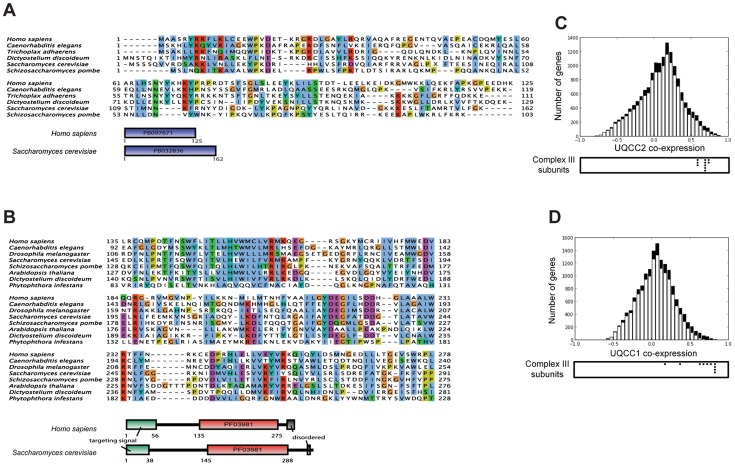
UQCC2 and UQCC1 are orthologous to the fungal complex III assembly factors Cbp6p and Cbp3p.Alignment between fungal and human complex III assembly factors was inferred using iterative orthology pipeline Ortho-Profile [26] and visualized using JalView with the ClustalX color scheme [65]. (A) Alignment of conserved regions among the orthologs of human UQCC2 and fungal Cbp6p. The S. cerevisiae-specific insertion between residues 47 and 96 is replaced with a letter X. The sequences do not have a recognizable targeting signal or additional conserved motifs. Domains were annotated according to PFAM [66]. (B) Alignment of UQCC1 (human) and Cbp3p (yeast) with orthologs in other eukaryotes. Only the conserved part of the sequence is shown in the alignment. Proteins contain the UQCC1-specific domain PF03981. (C and D) Mouse mRNA co-expression of UQCC2 (C) and UQCC1 (D) with other genes across 91 murine cell types and tissues. Black bars represent genes encoding mitochondrial proteins and white bars represent the remaining human genes. Below the chart the co-expression values of complex III subunits are indicated with black dots.